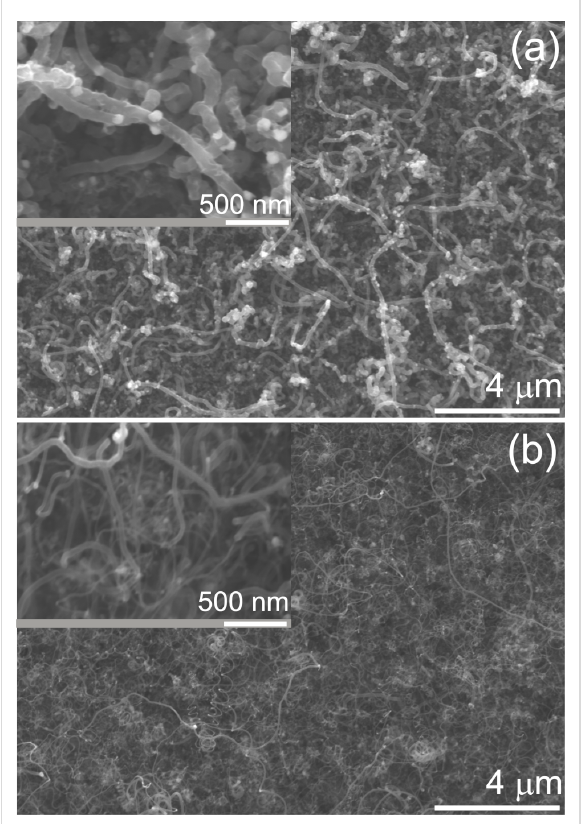
Figure 4: SEM images of (a) Fe nanoparticles electrodeposited onto primary CNTs and GC (8 s of deposition time) and (b) secondary CNTs grown at 750 °C for 120 min with a H 2 /Ar ratio of 2.4 (1.2 L h − 1 /0.5 L h − 1 ).